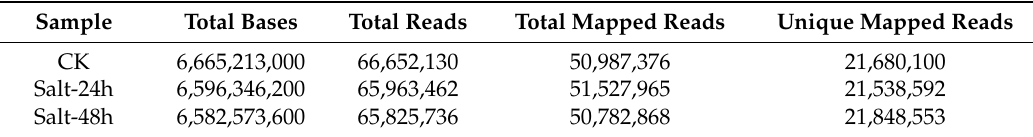
Table 5. The statistics of the differentially expressed